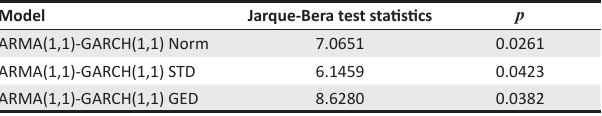
TABLE 3: Jarque-Bera test on standardised residuals of the ARMA(1,1)- GARCH(1,1) models. Model